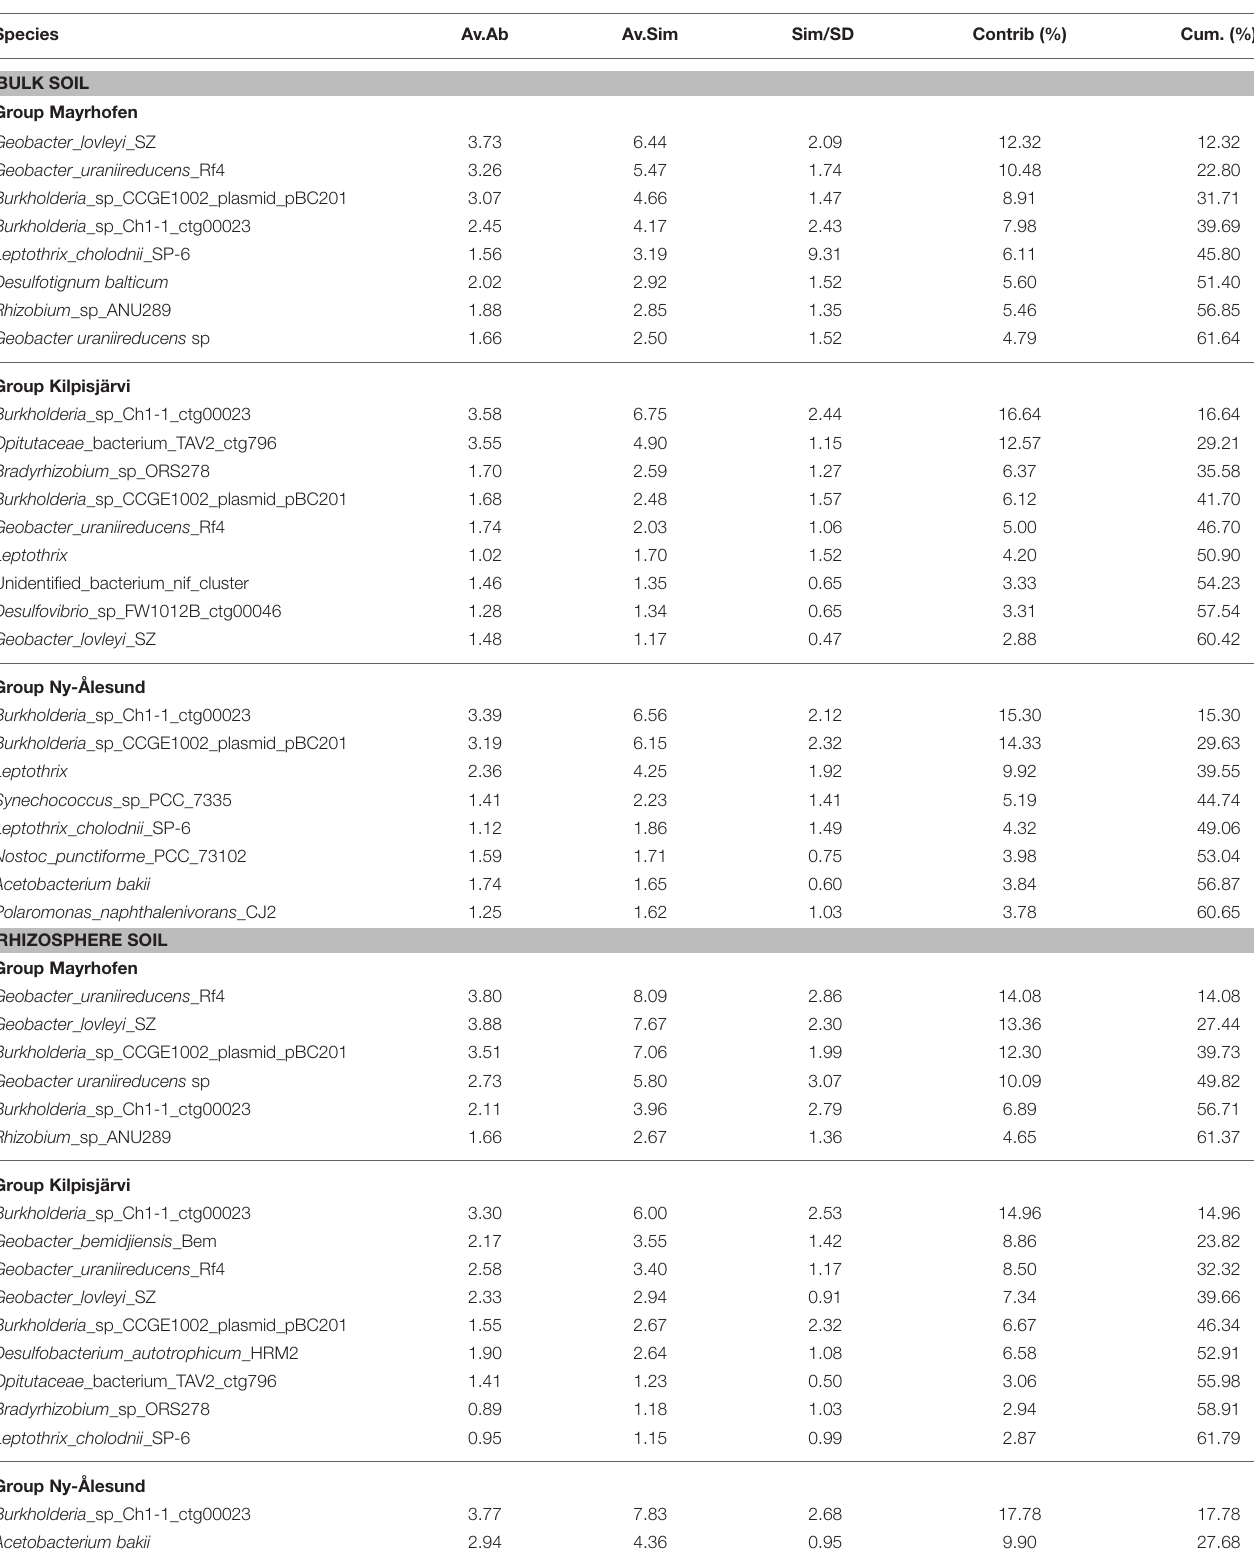
TABLE 2 | Top OPUs contributing up to 90% (endosphere) or 60% (rhizosphere and endosphere) cumulative similarity of PNFB communities in different regions are shown. Species Av.Ab Av.Sim Sim/SD Contrib (%) Cum.